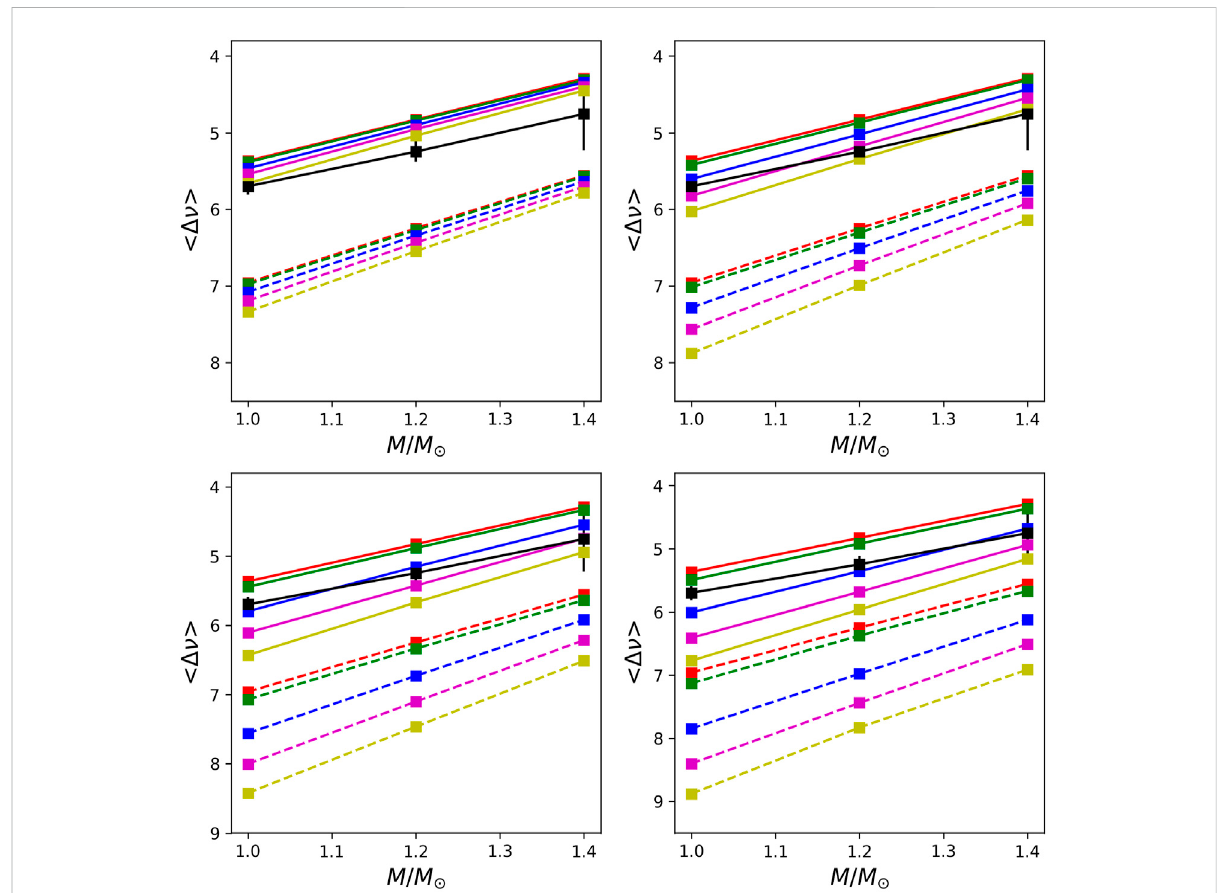
FIGURE 4 Variations of the large separation, Δ ] , vs. the initial mass M / M ⊙ for a set of simulations of RGB stars, introducing the production of dark photon models. Black line correspond to the observations of the large separation. The different panels correspond to m V (dark photon masses) of 300 eV (upper left panel), 500 eV (upper right), 700 eV (lower left) and 900 eV (lower right). For each panel the solid lines correspond to models with kinetic mixing( χ )valuesof χ =0(red), χ =2×10 – 15 (green), χ =5×10 – 15 (blue), χ =7×10 – 15 (magenta),and χ =9×10 – 15 (yellow).Dashedlinescorrespond to stellar models with χ given by the same color code, but considering a moderate core overshooting, α ov = 0.025. Taken from Ayala et al.